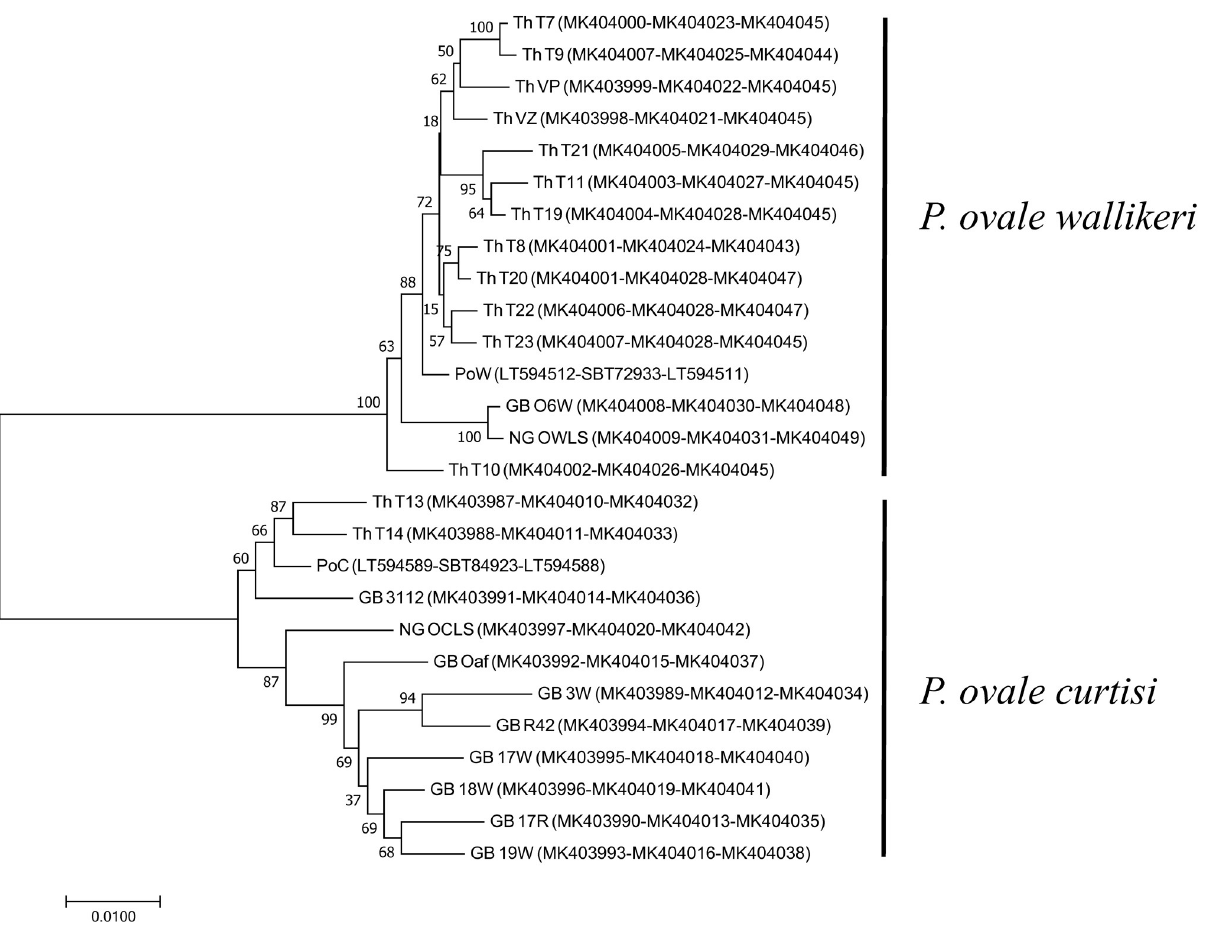
Fig 4. Phylogenetic analysis of P . ovale spp. Phylogenetic tree inferred using the Neighbor-Joining method based on concatenated CTRP, CSP, and MSP1 proteins. The percentage of replicate trees in which the associated taxa clustered together in the bootstrap test (1,000 replicates) are shown next to the branches. The evolutionary distances were computed using the JTT matrix-based method and are in the units of the number of amino acid substitutions per site. Accession numbers of CTRP-CSP-MSP1 of each sample is shown in the bracket.